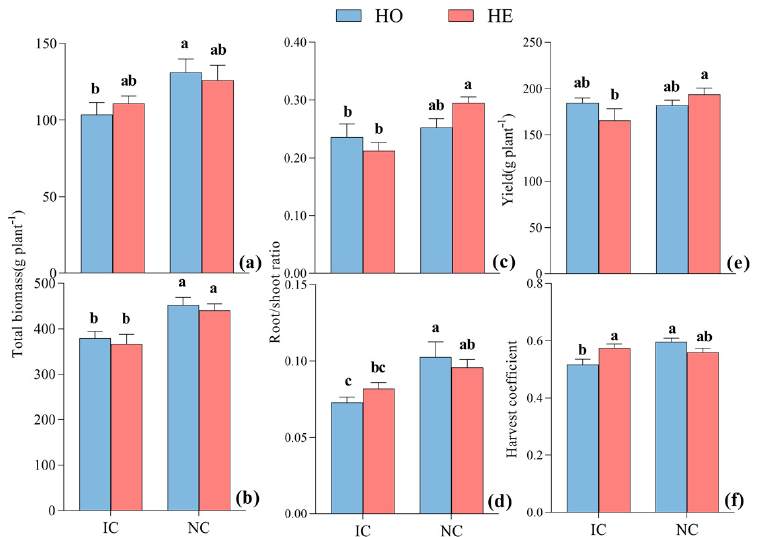
Figure 4. Effect of nitrogen distribution pattern and intraspecific competition on total biomass, root/shoot ratio, yield, and harvest coefficient of maize. ( a ) Total biomass at flowering stage. ( b ) Total biomass at mature stage. ( c ) Root/shoot ratio at flowering stage. ( d ) Root/shoot ratio at mature stage. ( e ) Yield. ( f ) Harvest coefficient.